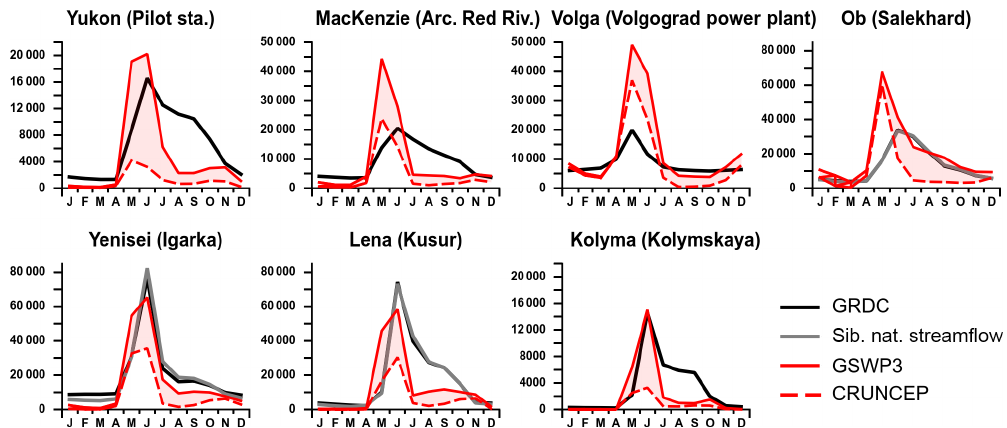
Figure 12. Monthly mean seasonal river discharge (m 3 s − 1 ) simulated with the two forcings compared to the observed non-naturalized (GRDC) and Siberian naturalized river discharge dataset at the gauge stations of the seven basins (see Fig. 2b), averaged over the period 1981–2007.